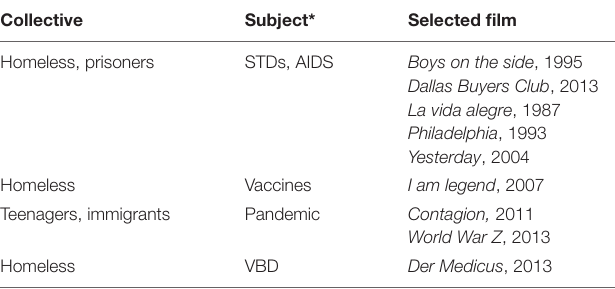
TABLE 2 | Selected films about infectious diseases used in the Service-Learning (S-L)